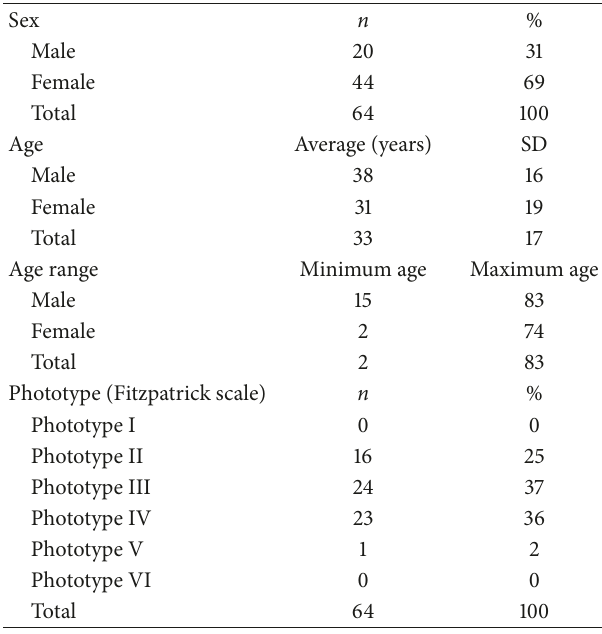
Table 2: Demographic information.